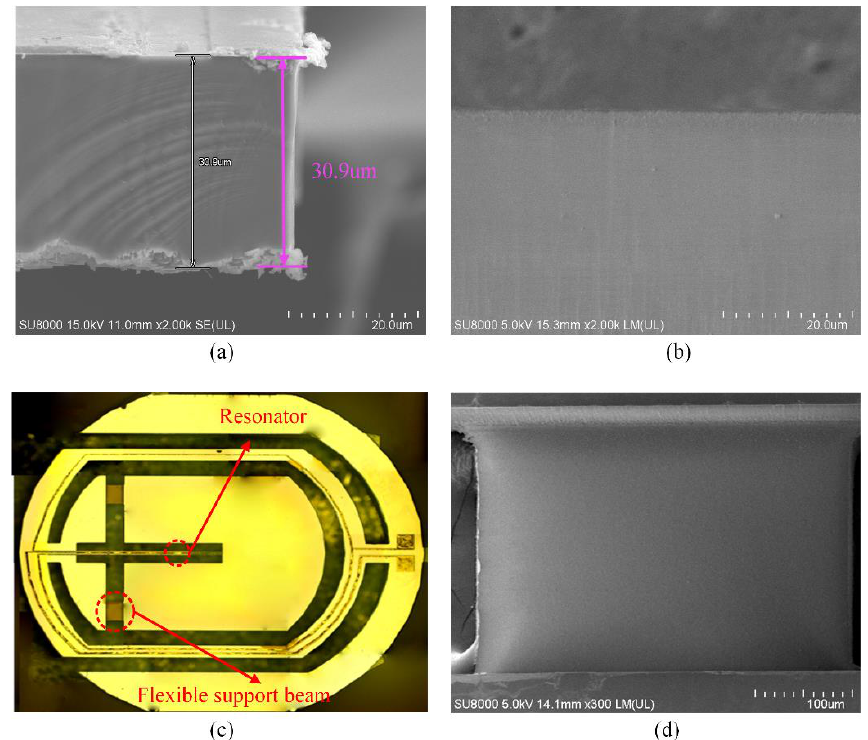
Figure 20. ( a ) The cross-section SEM image of the etched quartz resonator; ( b ) the SEM image of the etched sidewall; ( c ) the picture of the etched MEMS resonant device; ( d ) the SEM image of the etched bottom.